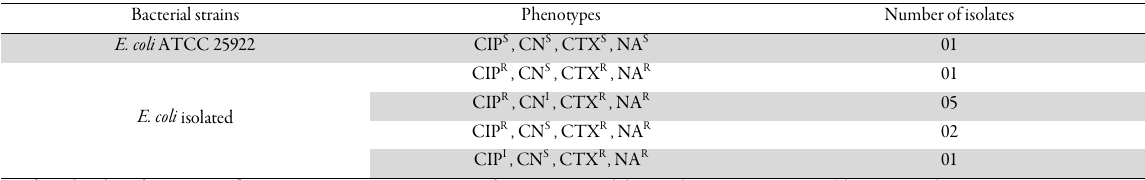
Table 4. Stem resistance profile of Escherichia